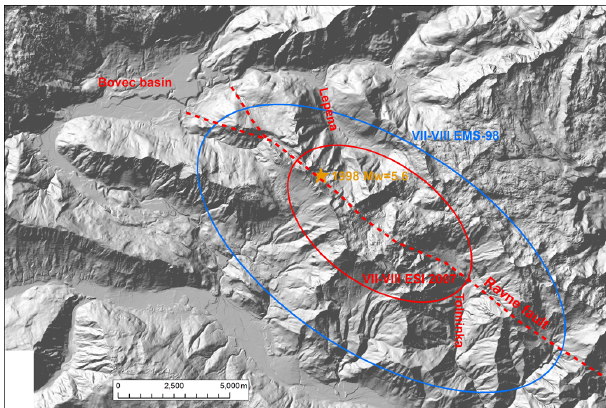
Fig. 9. Comparison of two isoseisms for 1998 earthquake: tentative VII–VIII EMS-98 isoseism from macroseismic data and VII–VIII ESI 2007 isoseism from environmental